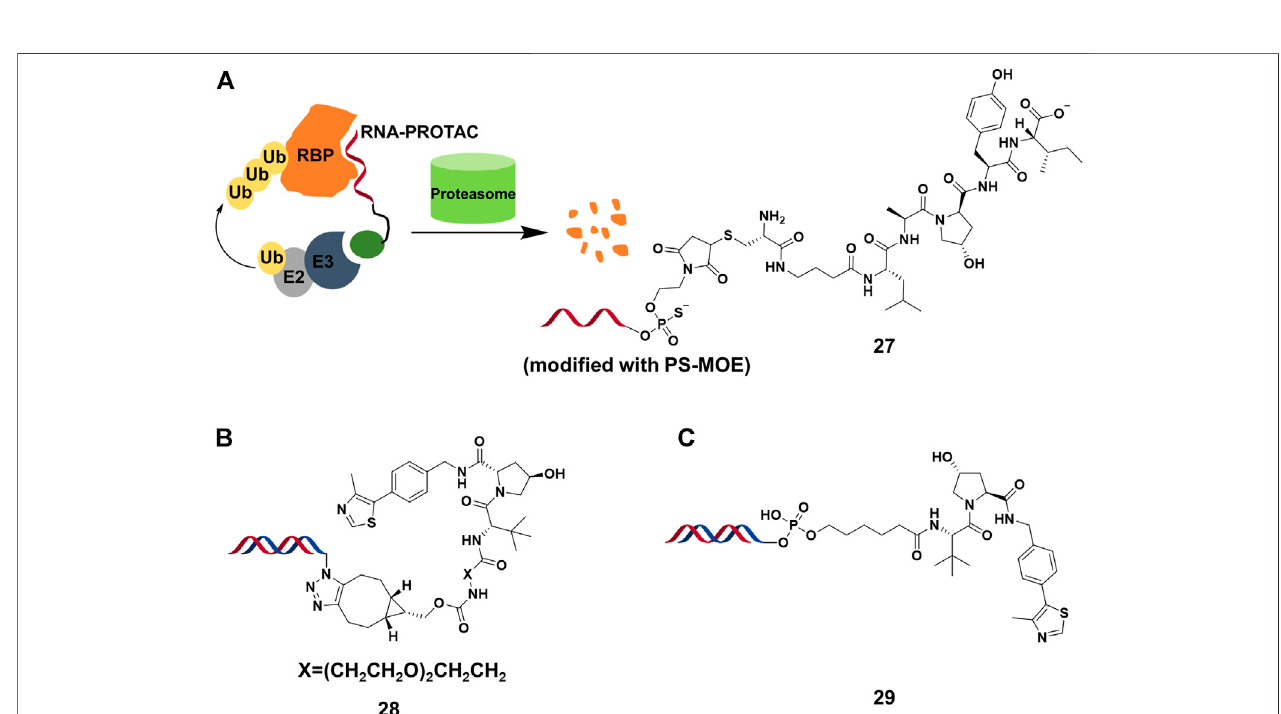
FIGURE9|(A) TheactionmodeandstructureofRNA-PROTACs. (B) StructureofTF-PROTACs. (C) Structureofoligonucleotide-basedPROTACs(O ’ PROTACs).